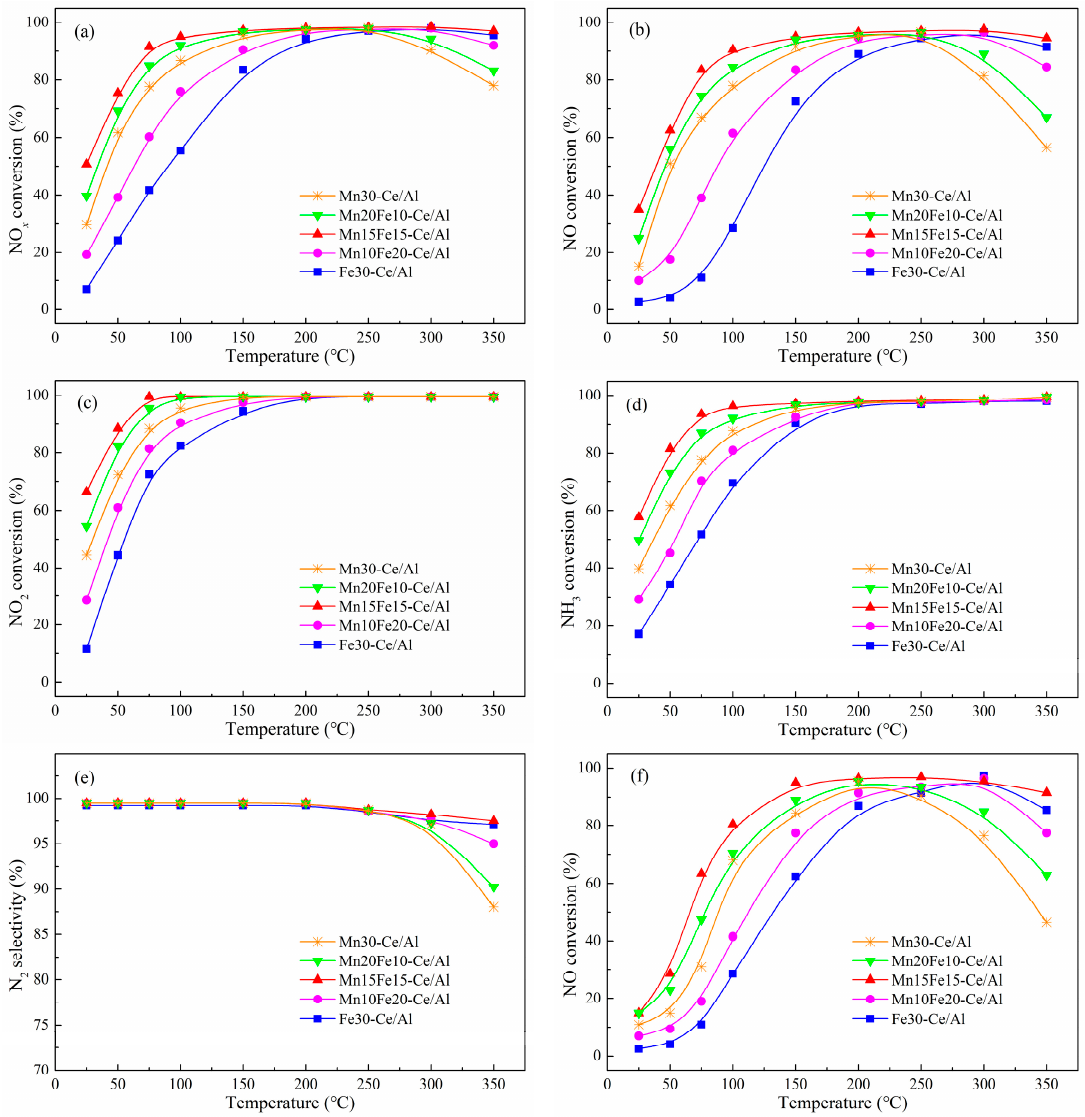
Figure 9. Fast SCR activity of Mn − Fe − Ce − O x / γ -Al 2 O 3 nanocatalysts. ( a – e ) 200 ppm NO, 200 ppm NO 2 , 400 ppm NH 3 , 5% O 2 , ~0.3% H 2 O and N 2 as balance gas; ( f ) 400 ppm NO, 400 ppm NH 3 , 5% O 2 , ~0.3% H 2 O and N 2 as balance.